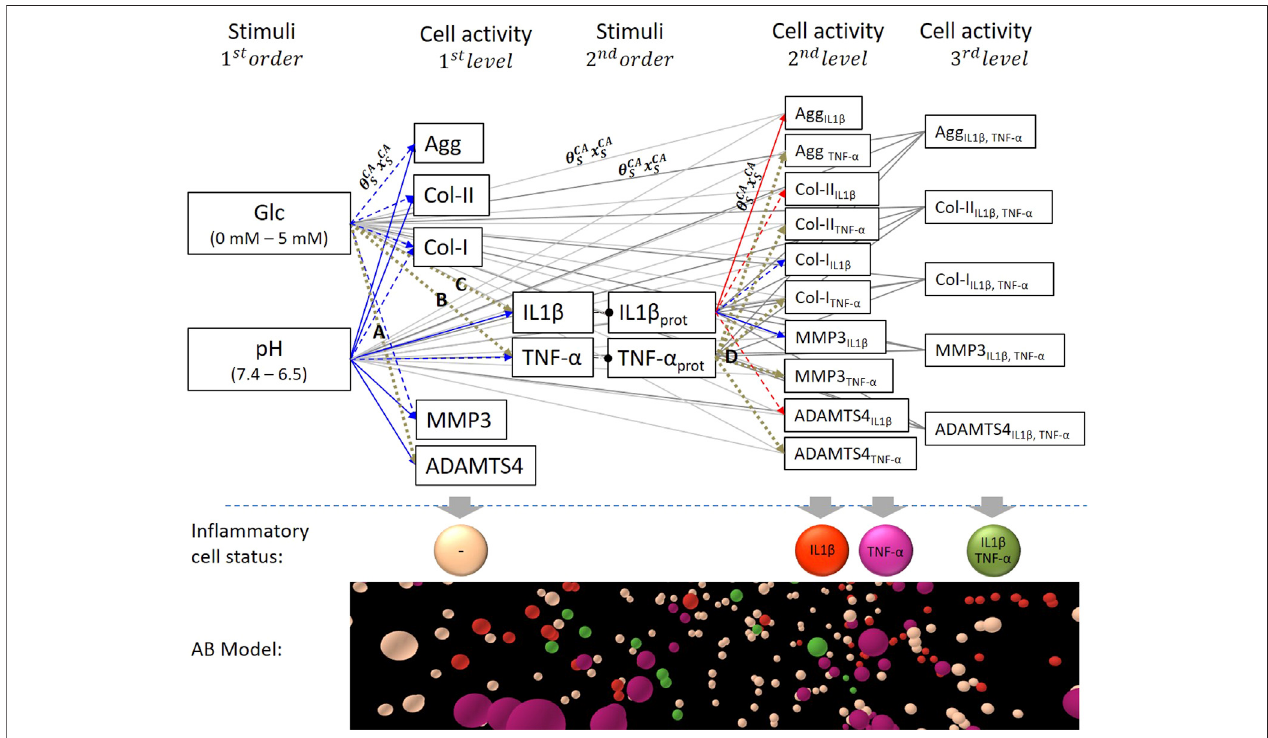
FIGURE 1 | System of interest based on nutrition-related stimuli glucose (glc) and pH. Stimulus – cell activity (S-CA) relationships were either activating (blue) or inhibiting (red) according to experimental fi ndings. Dashed blue and red arrows marked non-signi fi cant ( p > 0.05) relationships according to experimental fi ndings and browndotted arrows unknownS-CA relationships. Respective connections between1storderstimuliand 2nd/3rd level CAand 2ndorderstimuliand3rdlevel CAwere representedasgreylinestoprovideabettervisibility.EachS-CArelationshipisdeterminedbythesensitivityofaCAtoastimulustype(weightingfactor, θ CA S ) andby the sensitivity of a CA to a stimulus concentration ( x CA S ) (exemplarily illustrated within the system of interest). Resulting CA for different in fl ammatory cell states were calculated and displayed within a 3D Agent-based (AB) model.